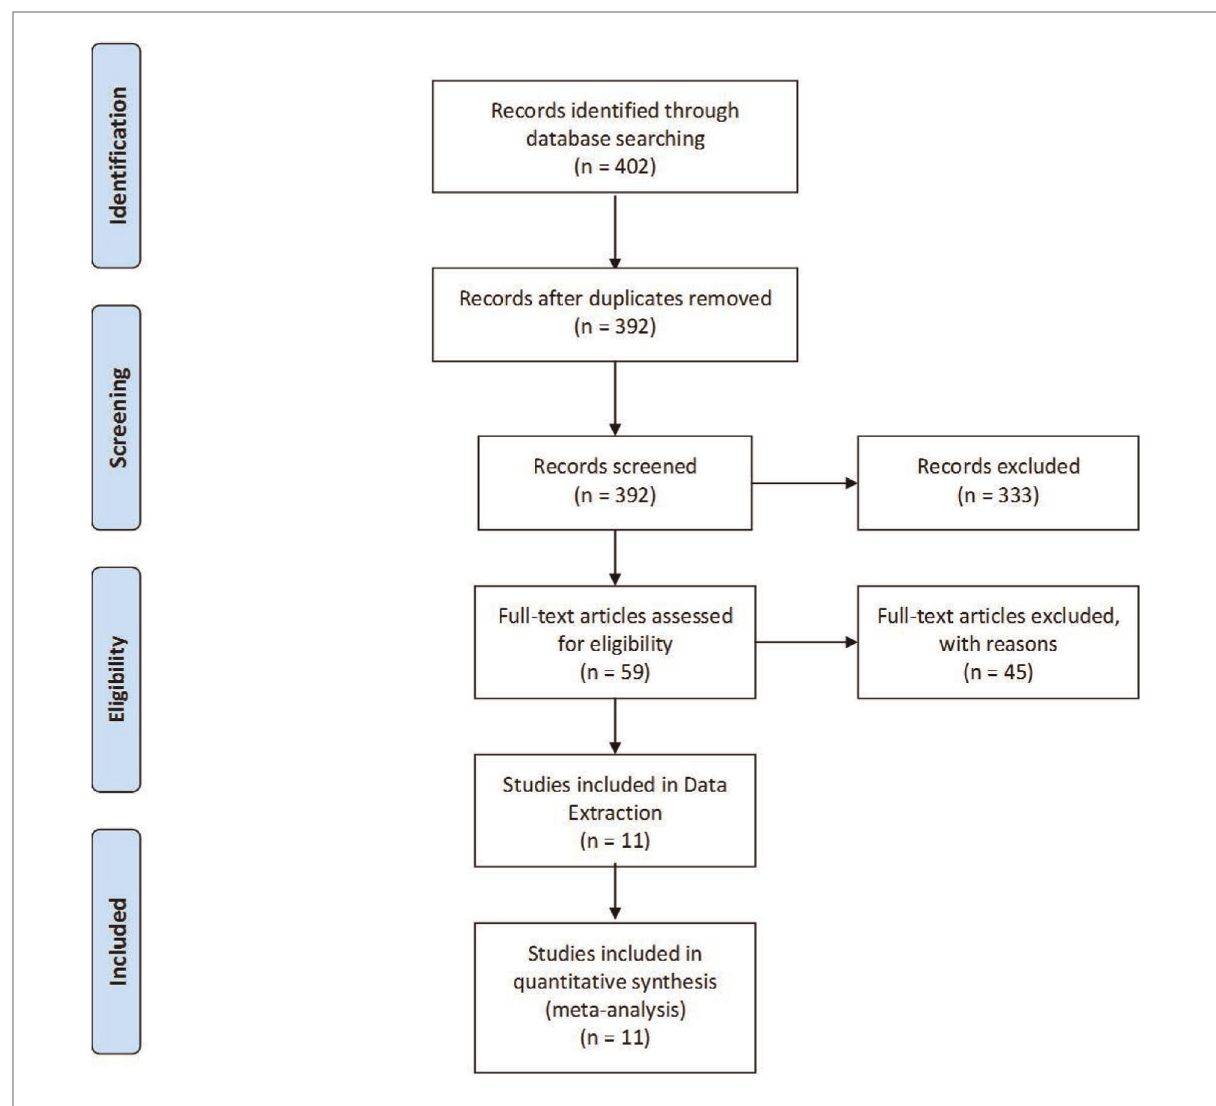
FIGURE 1 PRISMA fl ow